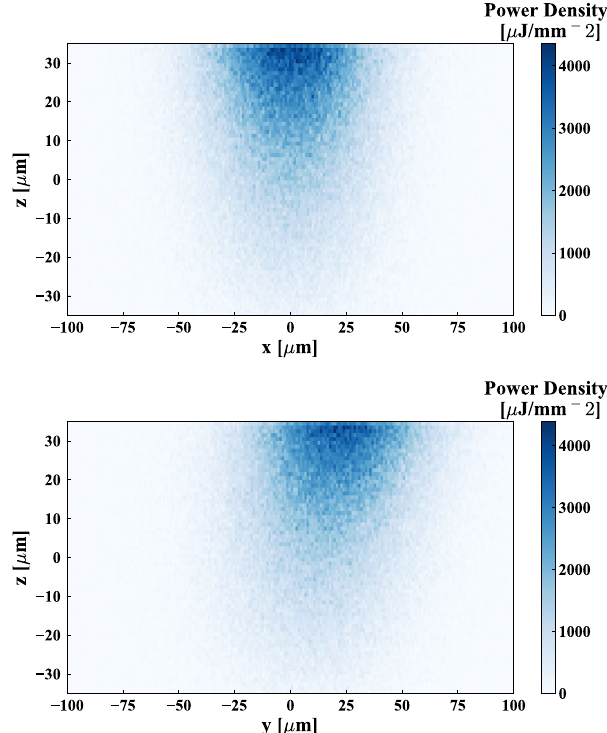
FIG. 6. The distribution of absorbed energy in x-z plane (top) and y-z plane (bottom).